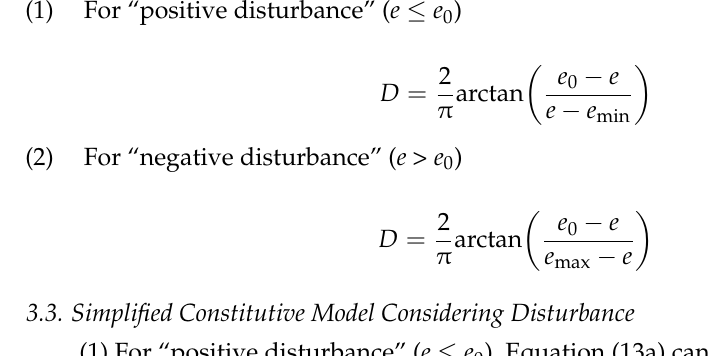
Figure 6. Relationship between the degree of disturbance and the void ratio.